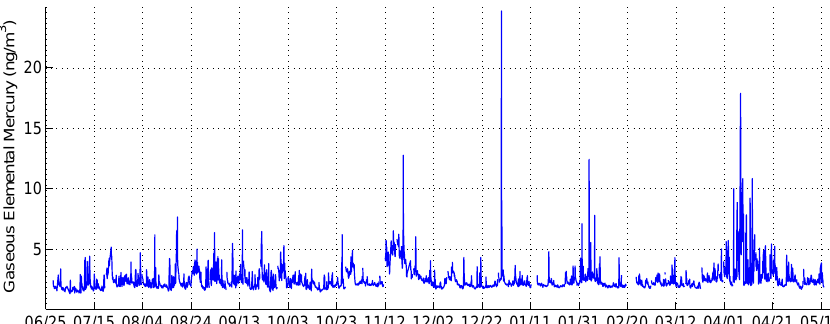
Fig. 4. Time Series of elemental gaseous mercury in Milwaukee from 28 June 2004 to 11 May 2005. This shows a combination of variations across time scales from short peaks lasting hours or less to longer events lasting days or even weeks.